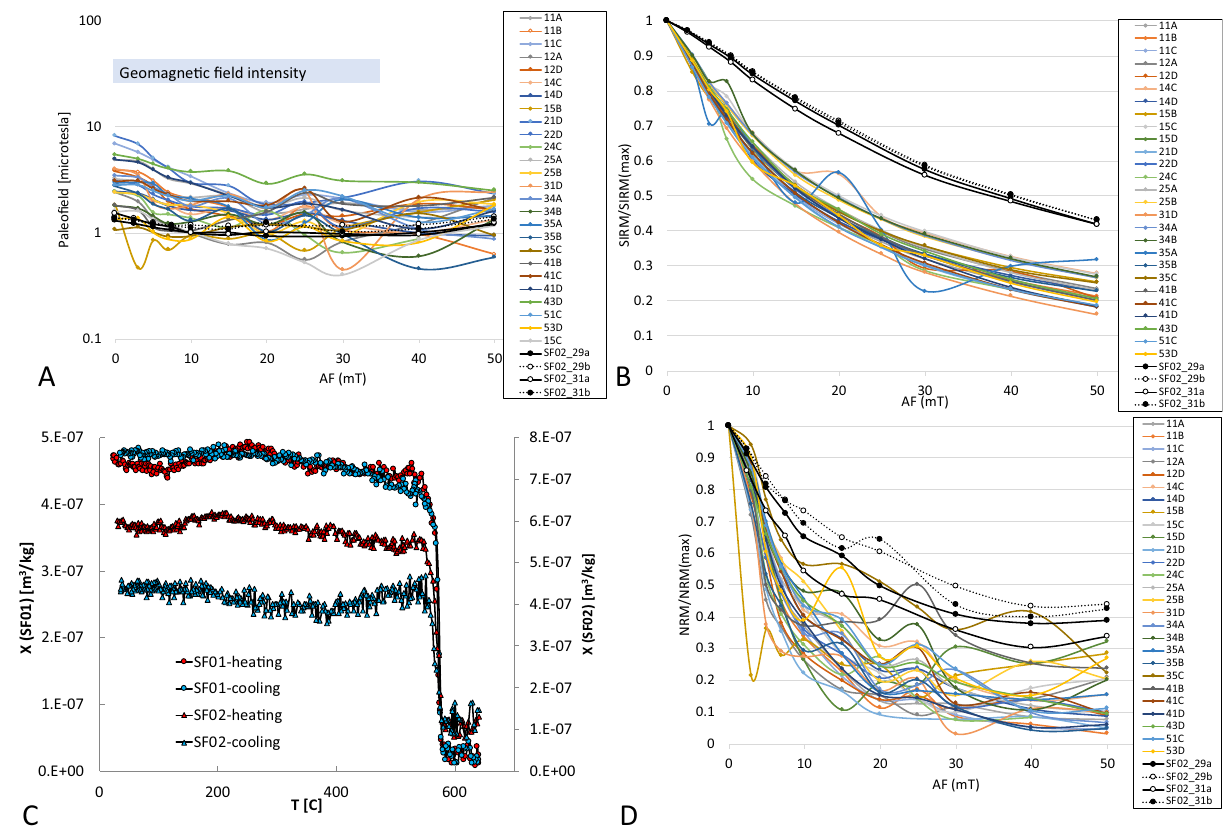
Figure 4. ( A ) Paleofield estimate is shown for 26 samples from SF01 and 4 samples from SF02 that are part of the Santa Fe impact rock containing shatter cone texture. Paleointensity estimates are calculated for each step of demagnetization by alternating field (AF) up to 50 mT. Geomagnetic field intensity range during the last 2 billion of years is labelled and general range indicated by gray panel. ( B ) Demagnetization of SIRM (Saturation isothermal remanent magnetization) is shown for 26 samples from SF01 and 4 samples from SF02 that are part of the Santa Fe impact rock containing shatter cone texture. ( C ) Curie temperature in samples from SF01 and SF02 was estimated by measurement of magnetic susceptibility with increasing temperature. Major drop in susceptibility X near 575 C is consistent with magnetite as the magnetic carrier of these two rocks. ( D ) Demagnetization of NRM (Natural Remanent Magnetization) is shown for 26 samples from SF01 and 4 samples from SF02 that are part of the Santa Fe impact rock containing shatter cone